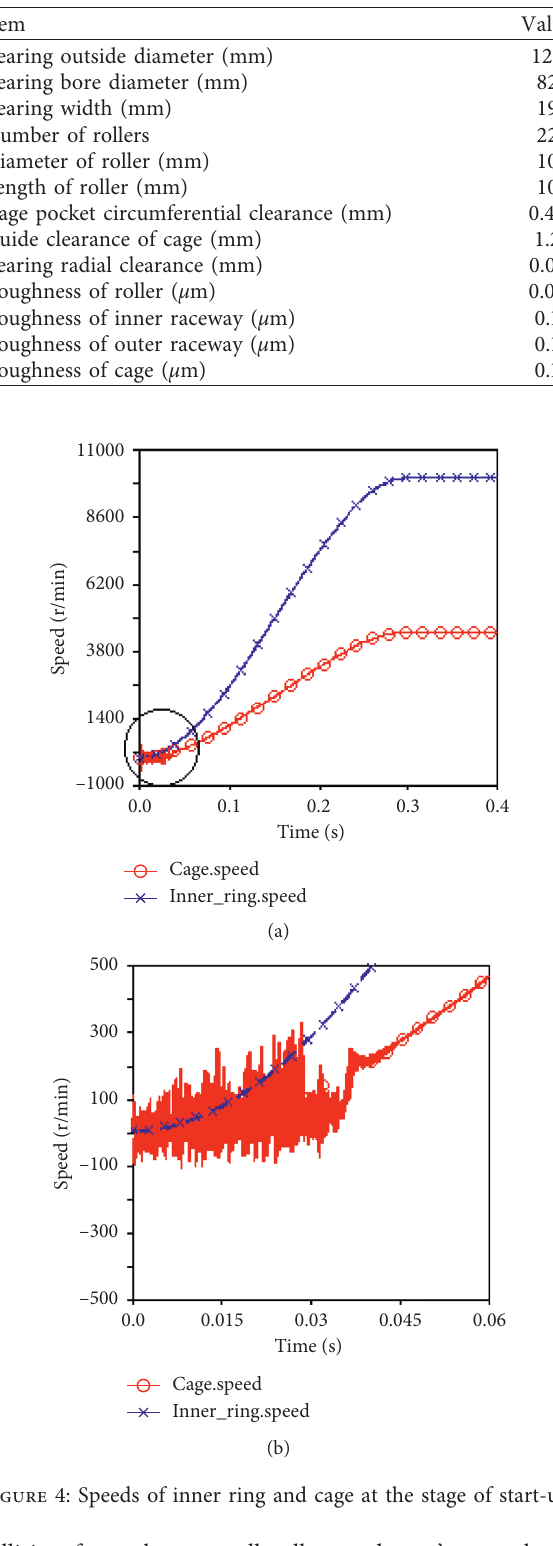
Table.1: The main parameters of bearing.